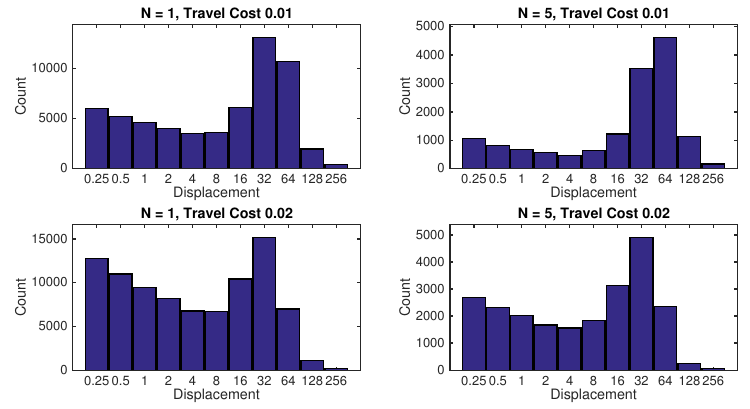
Figure 5. Histograms of robot formation displacements, as chosen by the search algorithm. The travel cost per unit distance was α = 0.01 and α =